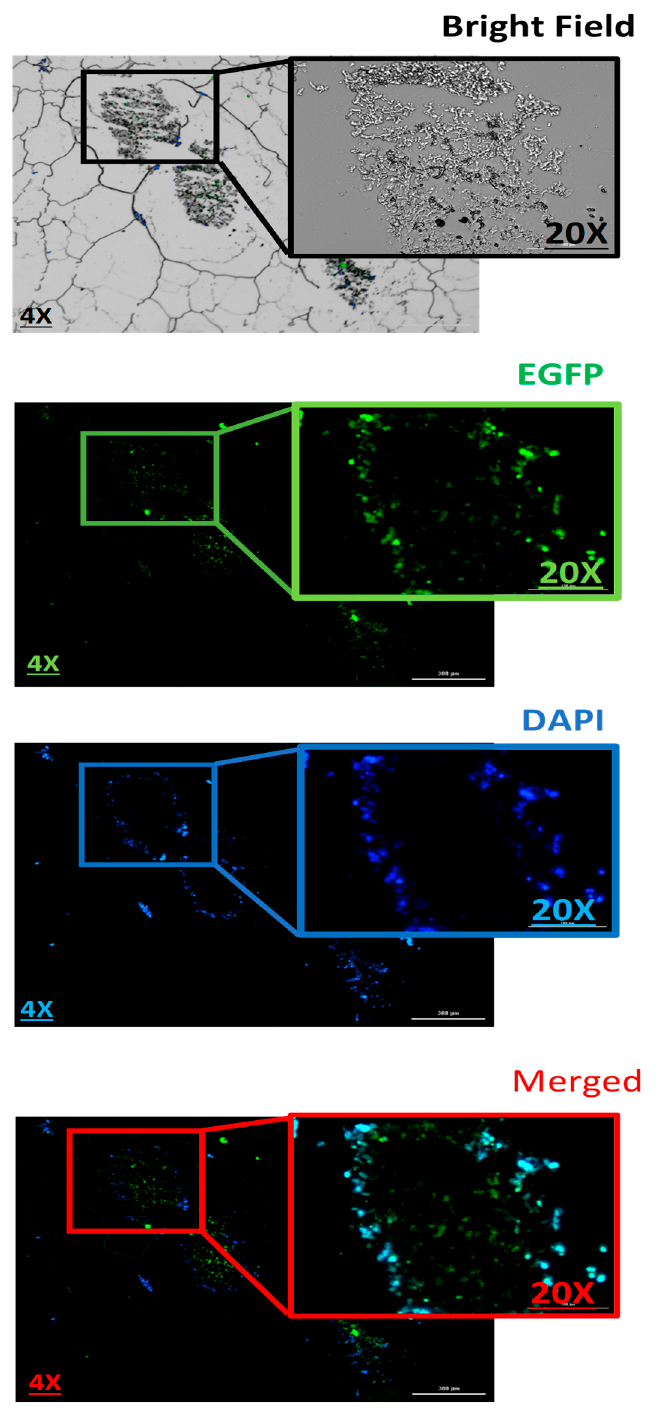
Figure 8. Evaluation the 3D spheroid cells on paraffin-embedded cell block to confirm the spatial pression of EGFP inside the spheroids. Scale bars: 4 × and 20 × . DNA refers to the pmaxGFP expression of EGFP inside the spheroids. Scale bars: 4× and 20×. DNA refers to the pmaxGFP plas- mid.